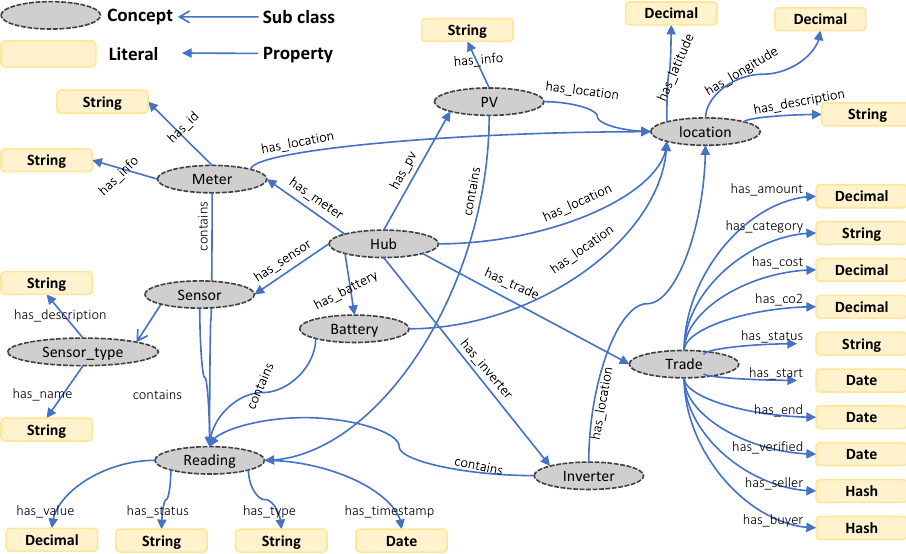
Figure 1. An ontology-based data integration and standardisation scheme to tackle diverse data sources and formats